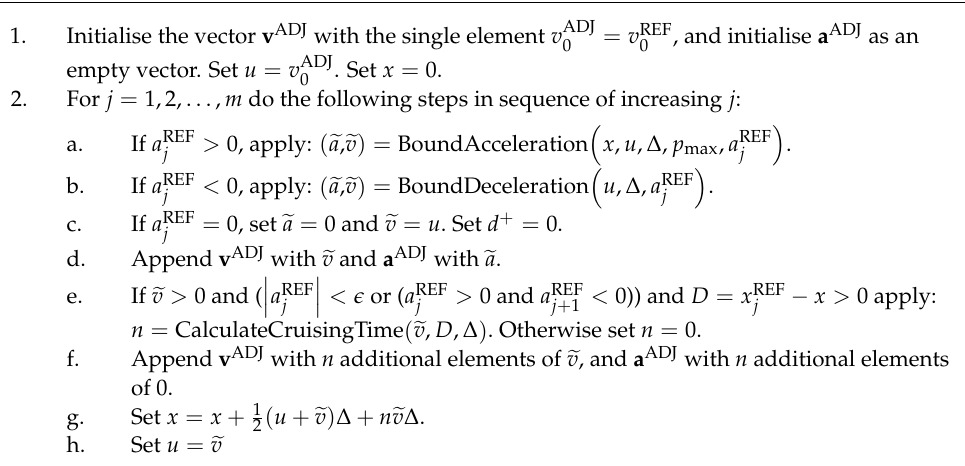
Algorithm 1. Overall solution